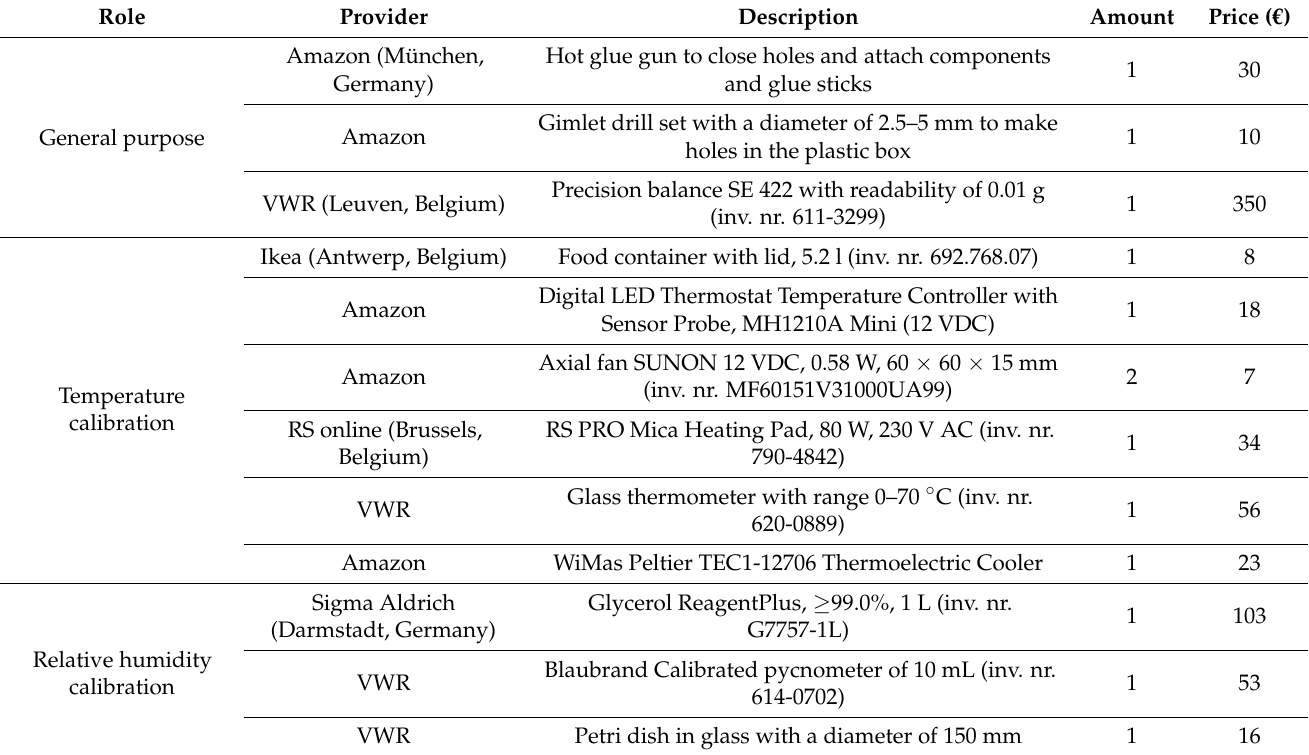
Table 2. Components that are needed to build the calibration setups shown in Figures 1–4. Medical disposables were locally purchased from a medical